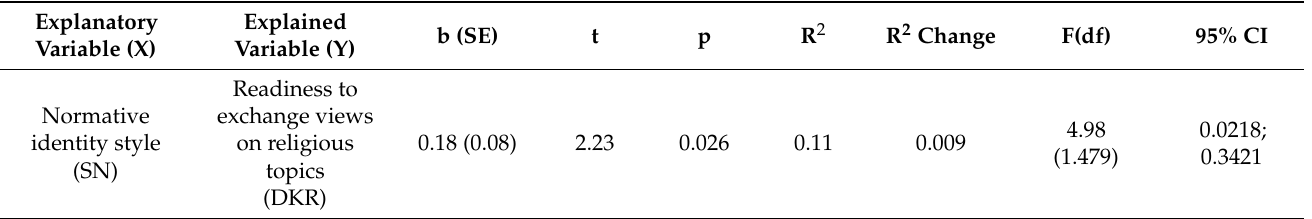
Table 2. Internal religiousness as a moderator of the relationships between identity styles and readiness to enter into interreligious dialogue.